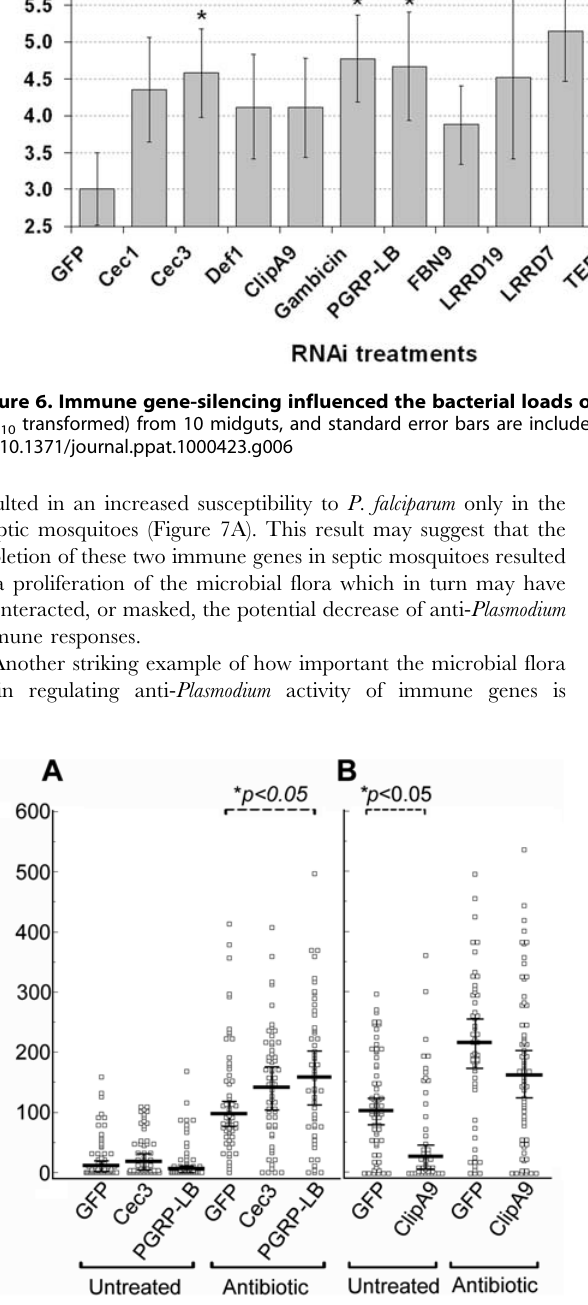
Figure 7. The depletion of PGRP-LB, Cec3, and ClipA9 through RNAi gene silencing resulted in the changes of P.falciparum oocyst intensity in the septic (untreated) and aseptic (antibi- otic-treated) mosquitoes. Points indicate the absolute value of oocysts counts in individual mosquitoes, and horizontal black bars in each column represent the median value of oocysts from three replicates where the narrow black bars above or below the median values indicate the standard errors. p -values were calculated through a Kruskal-Wallis test. (A) P. falciparum oocyst intensity increased in aseptic mosquitoes (Antibiotic) when Cec3 or PGRP-LB was silenced. dsGFP injected mosquitoes (GFP) were used as controls. (B) P. falciparum oocyst intensity decreased in septic mosquitoes (Untreated) when ClipA9 was silenced.